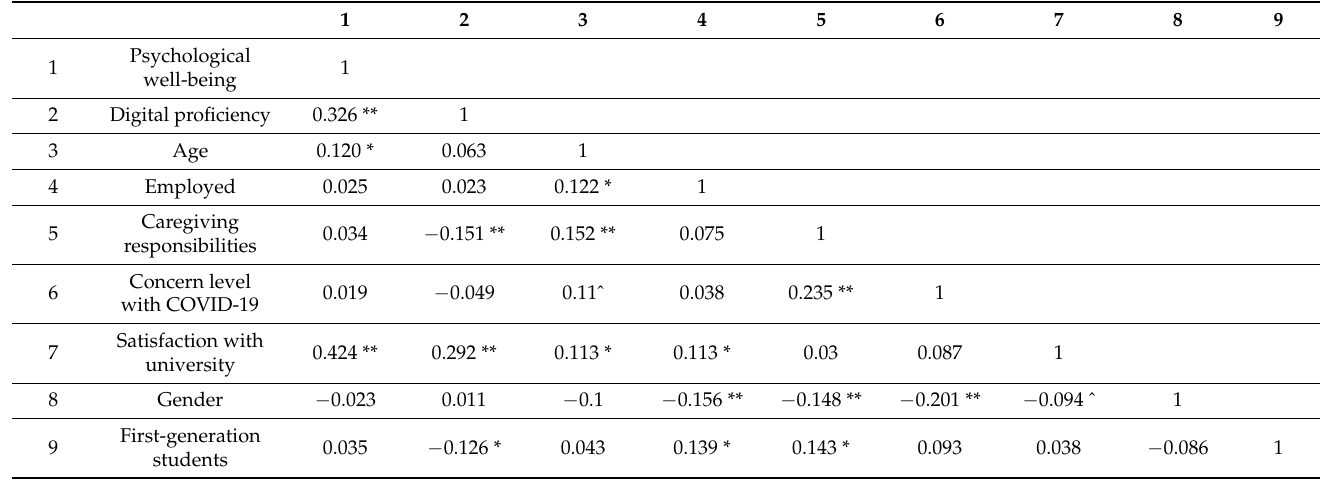
Table 1. Correlational